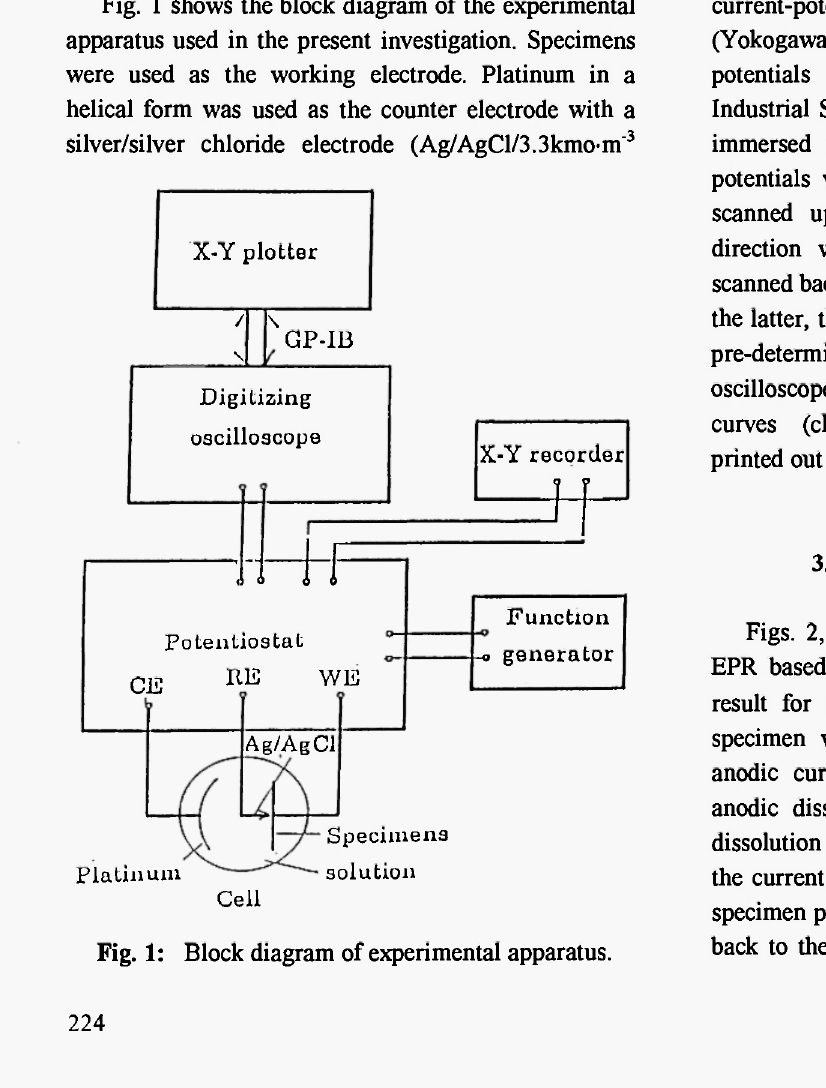
Fig. 1: Block diagram of experimental